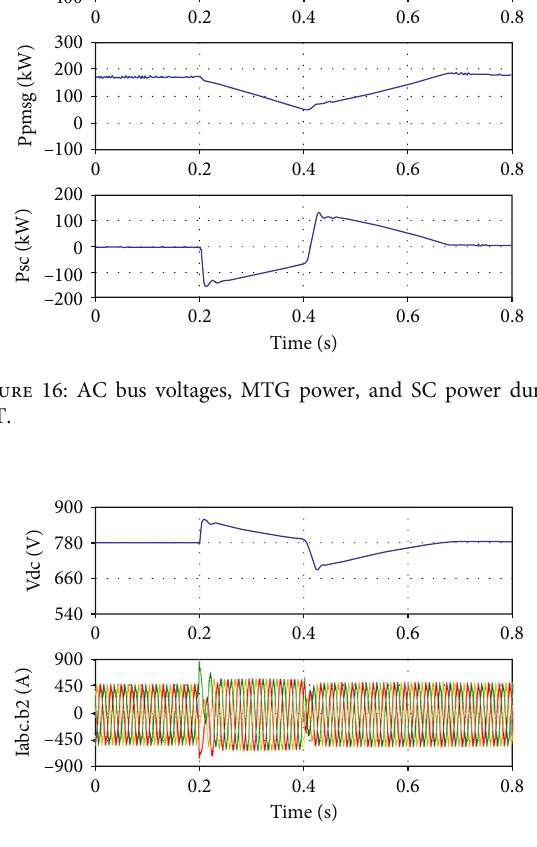
Figure 17. MTG power changes continuously between 0.2 s and 0.4 s, while SC power changes quickly to reduce the DC-link voltage deviation.